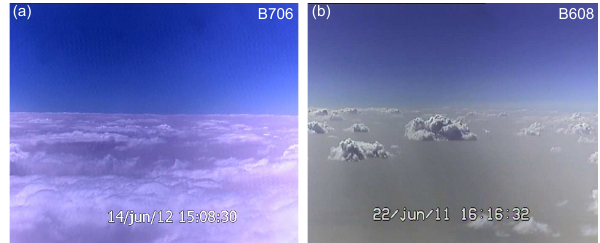
Figure 4. Snapshot from the BAe146 rearward-facing digital cam- era at (a) 15:08UTC during B706 and (b) 16:16UTC during B608, showing the cloud horizontal extent and structure of the cloud in each scene. Note the strong contrast in (b) between the dusty SABL and the free atmosphere above, with the clouds lying at this bound-